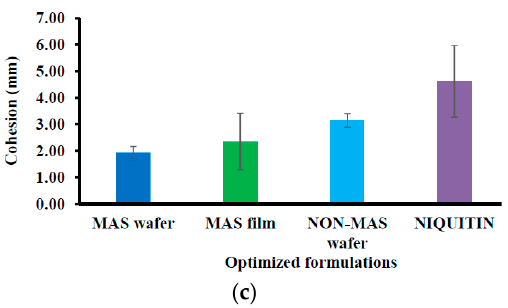
Figure 4. Mucoadhesive profiles of NiQuitin ® and HPMC–SA wafers and films ( n = 3, ± SD) in the presence of SS: ( a ) peak adhesive force (N), ( b ) total work done (Nmm), ( c ) cohesiveness (mm).